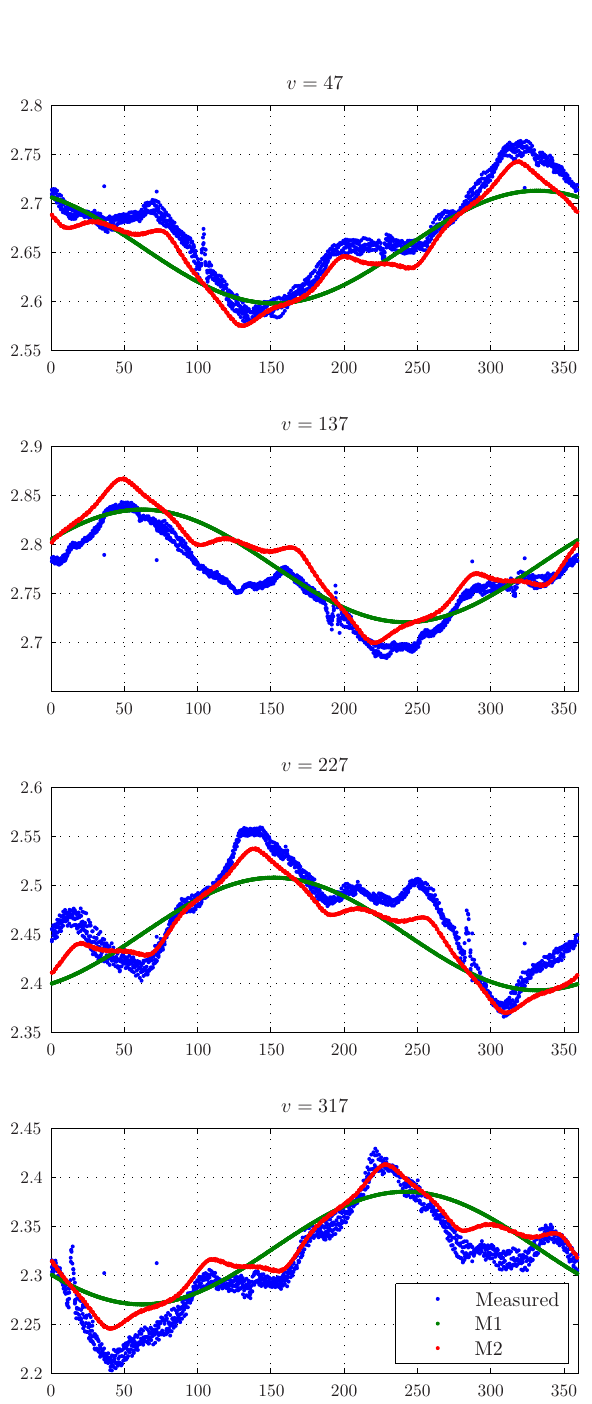
Figure 9: Measurements plotted together with results from the parameter